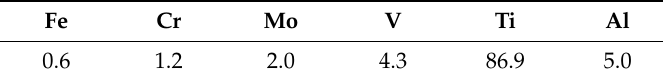
Table 1. Chemical composition of VT23 titanium alloy (wt %).